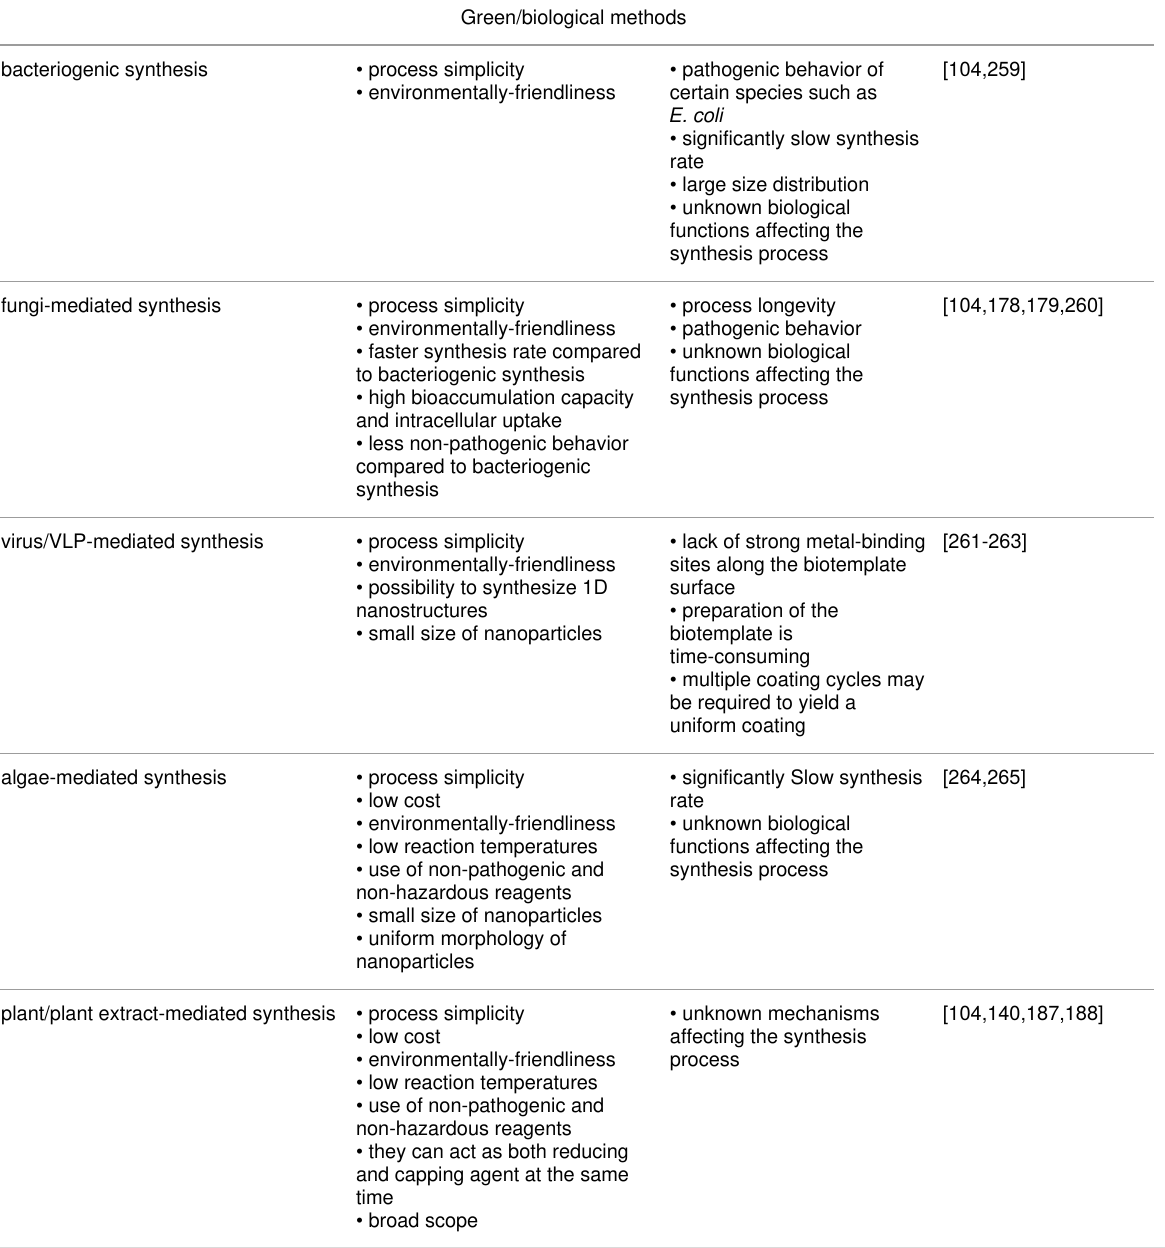
Table 1: Classification and comparison of various synthesis methodologies of silver nanostructures based on their advantages and disadvantages as reported in the literature. (continued) Green/biological